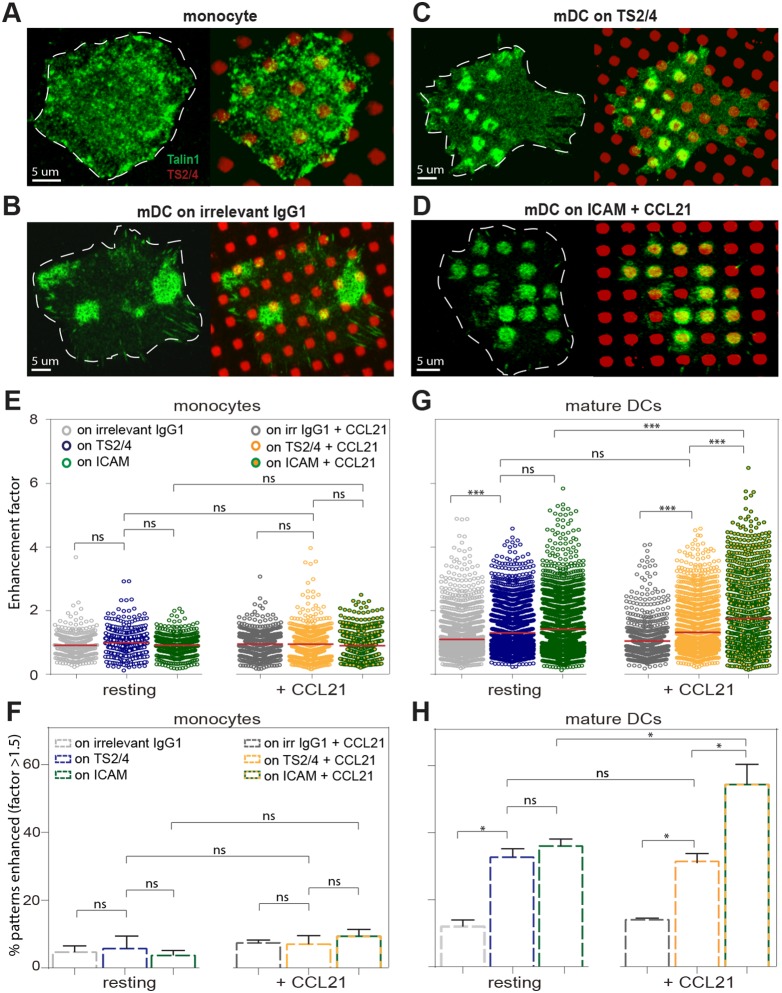
Localization of Talin1 to LFA-1 on monocytes and mDCs.(A, B) Representative images of (A) a monocyte seeded on a TS2/4 pattern, (B) a resting mDC on irrelevant IgG1 pattern, (C) a resting mDC seeded on a TS2/4 pattern and (D) a CCL21 activated mDC seeded on a ICAM-1 pattern. Green corresponds to Talin1 and red to the location of IgG1, TS2/4 or ICAM-1 positive squares. Cells are delineated by white lines. (E) Quantification of the degree of Talin1 enhancement to the positive areas in monocytes in different conditions (see Methods). Mean enhancement factor is displayed in red per condition. (F) Percentage of positive squares per experiment (n = 3, each a different donor) that showed significantly enhanced Talin1 signal per condition in monocytes. An enhancement factor of ≥1.5 was considered significantly enhanced, since 95% of the control sample (monocytes on IgG1) showed an enhancement factor below this value. (G) Quantification of the degree of Talin1 enhancement to the positive areas in mDCs in different conditions (see Methods). Mean enhancement factor is displayed in red per condition. (H) Percentage of positive squares per experiment (n = 3, each a different donor) that showed significantly enhanced Talin1 signal per condition in mDCs. Around 60 cells of 3 different donors were analyzed per condition. Monocytes contained 10 positive areas on average per cell, while mDCs contained around 50 positive areas. Means ± SEM are depicted. The Kruskal-Wallis test, followed by Dunn’s multiple comparison test was used to determine significant differences between means in E and G. The One-way ANOVA followed by the Tukey’s multiple comparison test were used to determine significant differences between means in F and H. The resulting P values are indicated as follows: ns (P>0.05); * (P<0.05) and *** (P<0.0001).